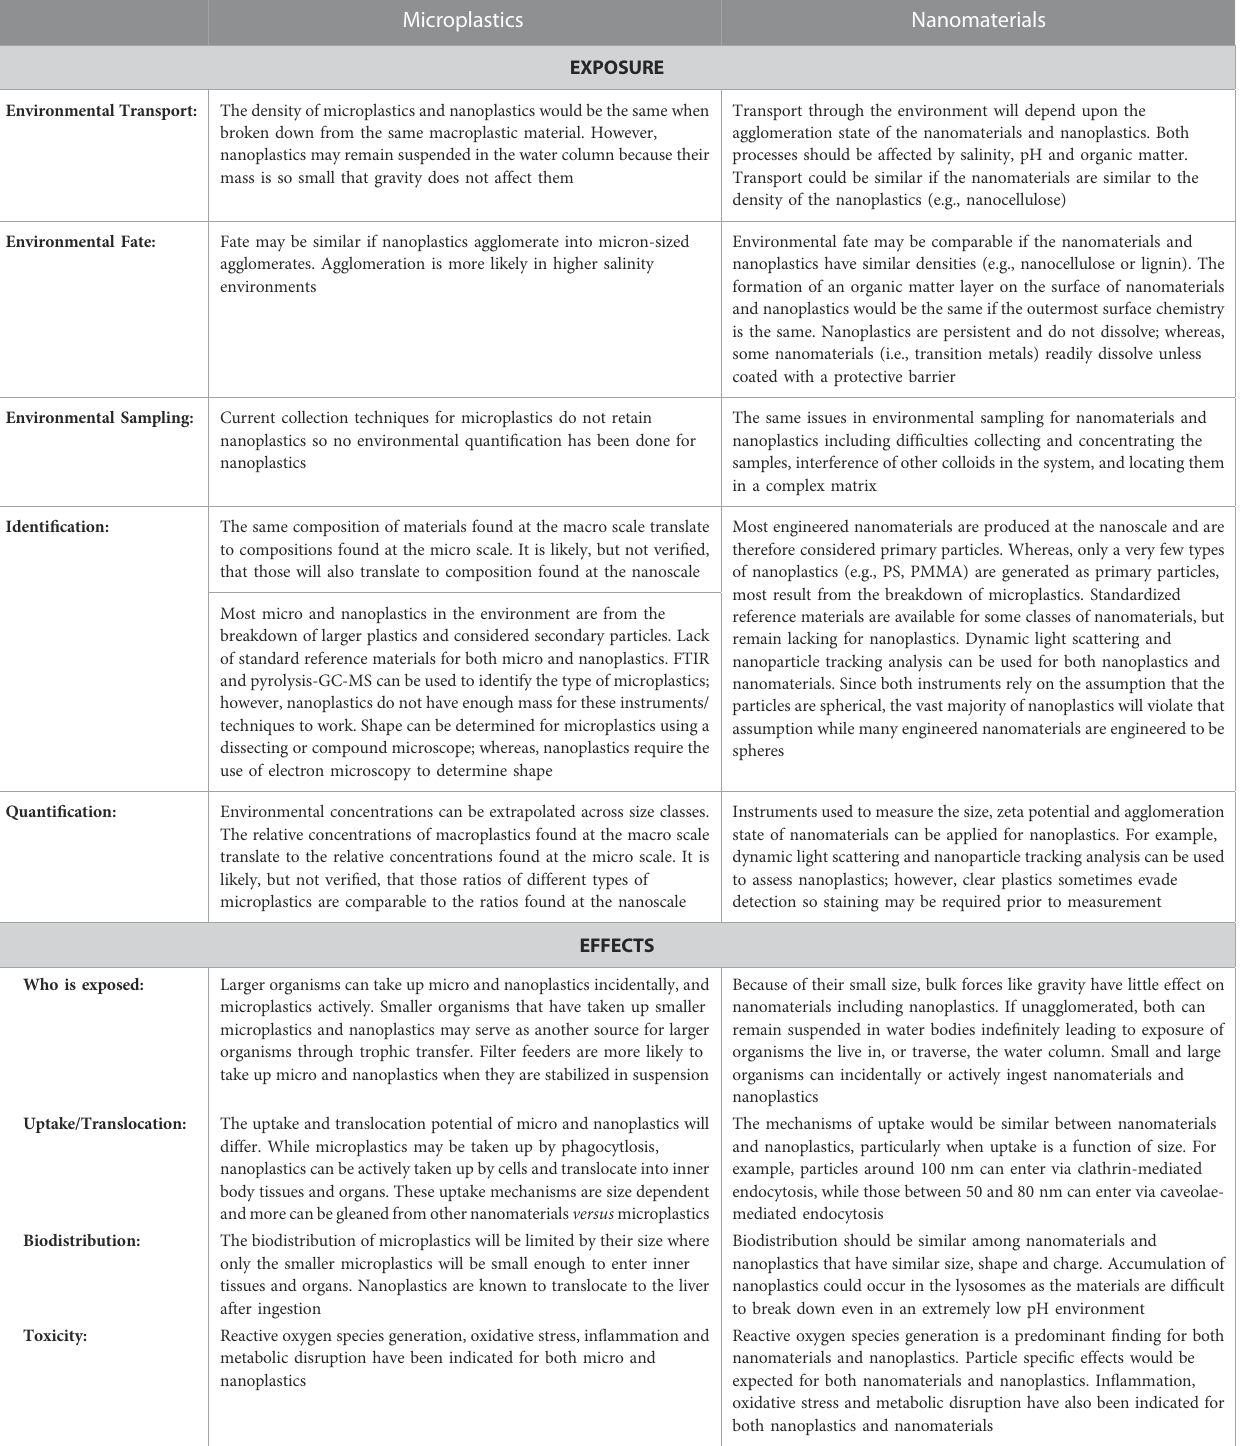
TABLE 1 What we can and cannot draw from microplastics and nanomaterials research to inform nanoplastics risk